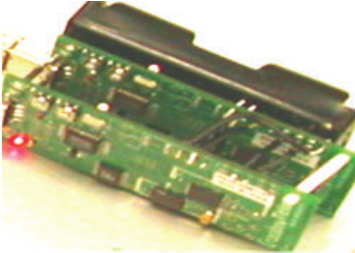
Figure 1: Cognitive radio